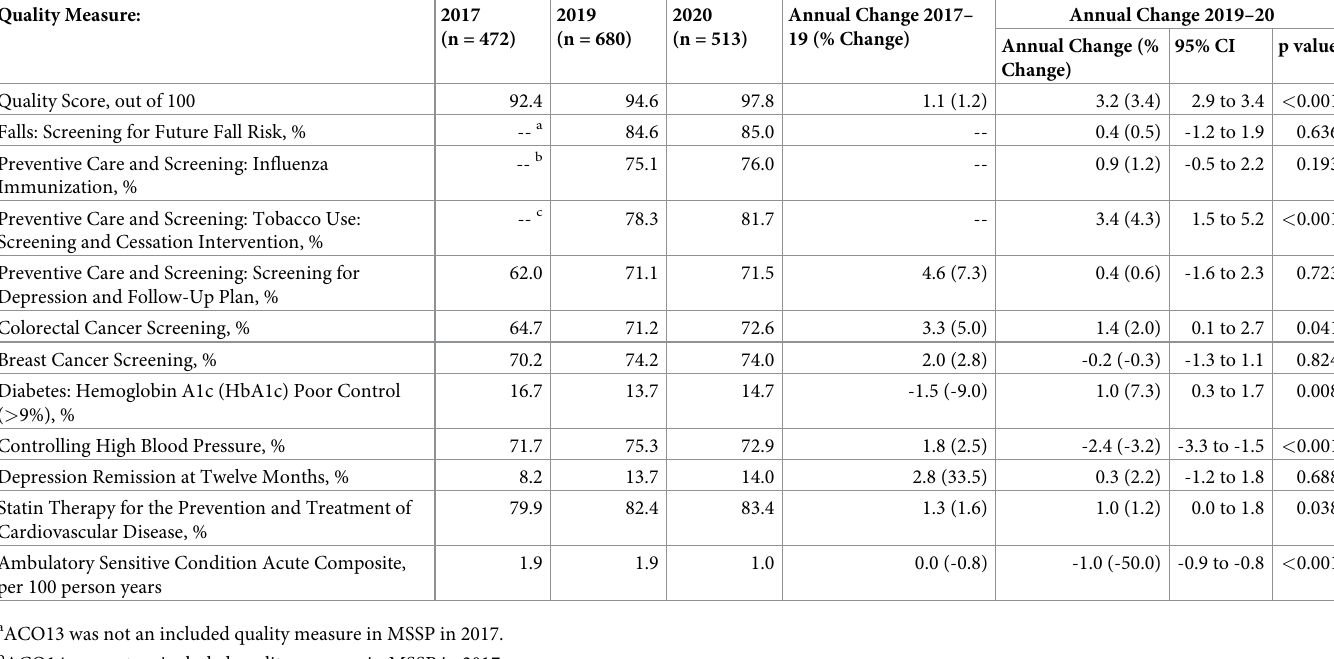
Table 3. Changes in quality scores,